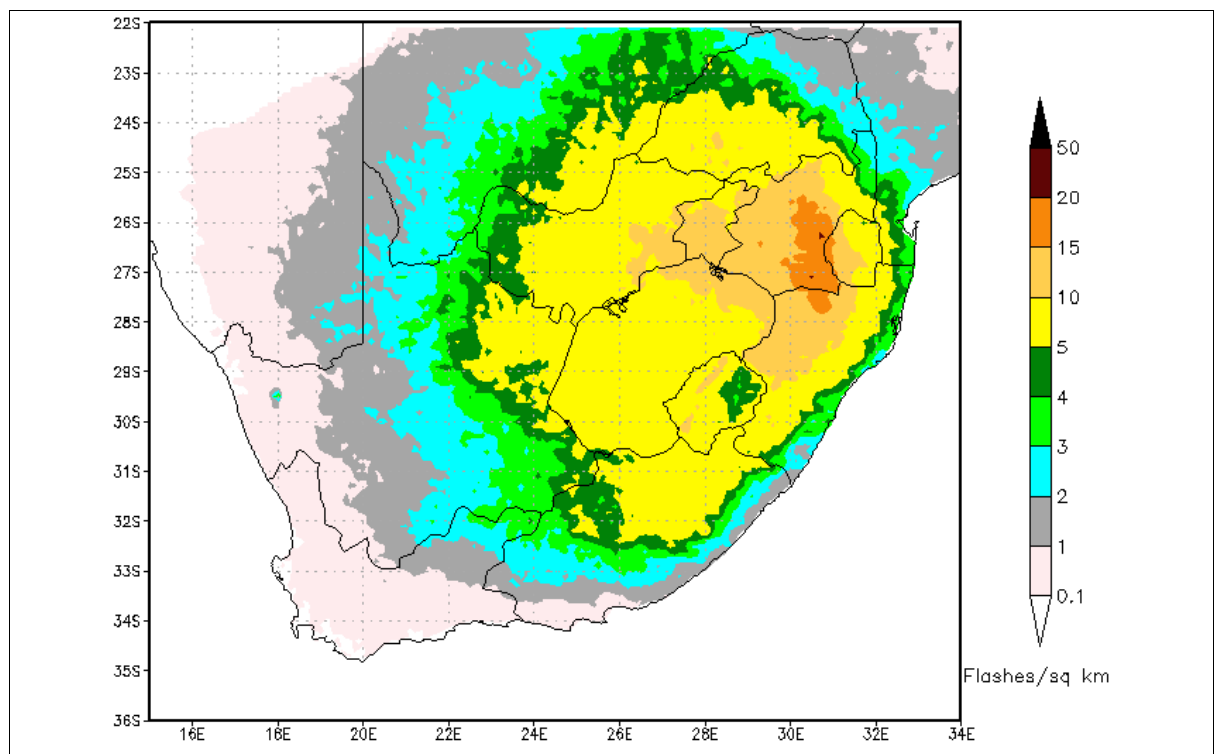
Figure 4: Average number of lightning ground flashes per km 2 per year over South Africa for the 8-year period (2008–2015).